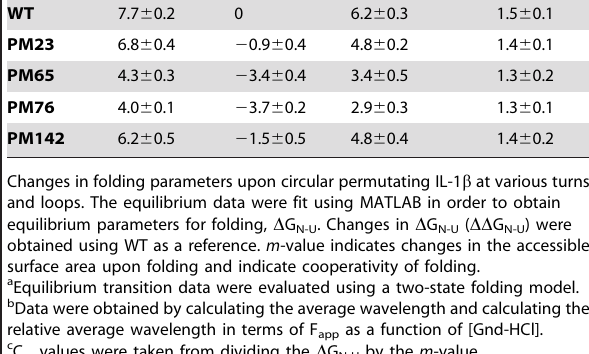
highlighted as red spheres in Figure 3C. These residues are: L60, L62, C71, Q116, I122, S123, and L134. Interestingly, surface